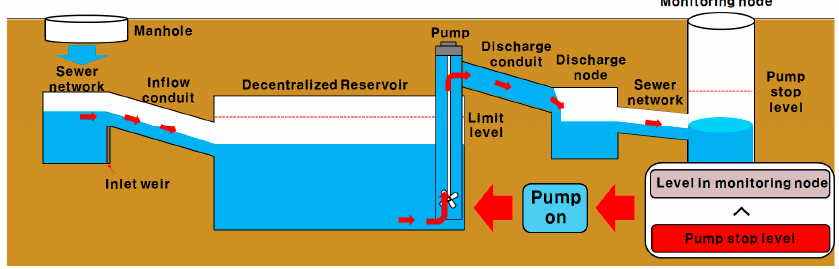
Figure 6. New operation method for a decentralized reservoir.